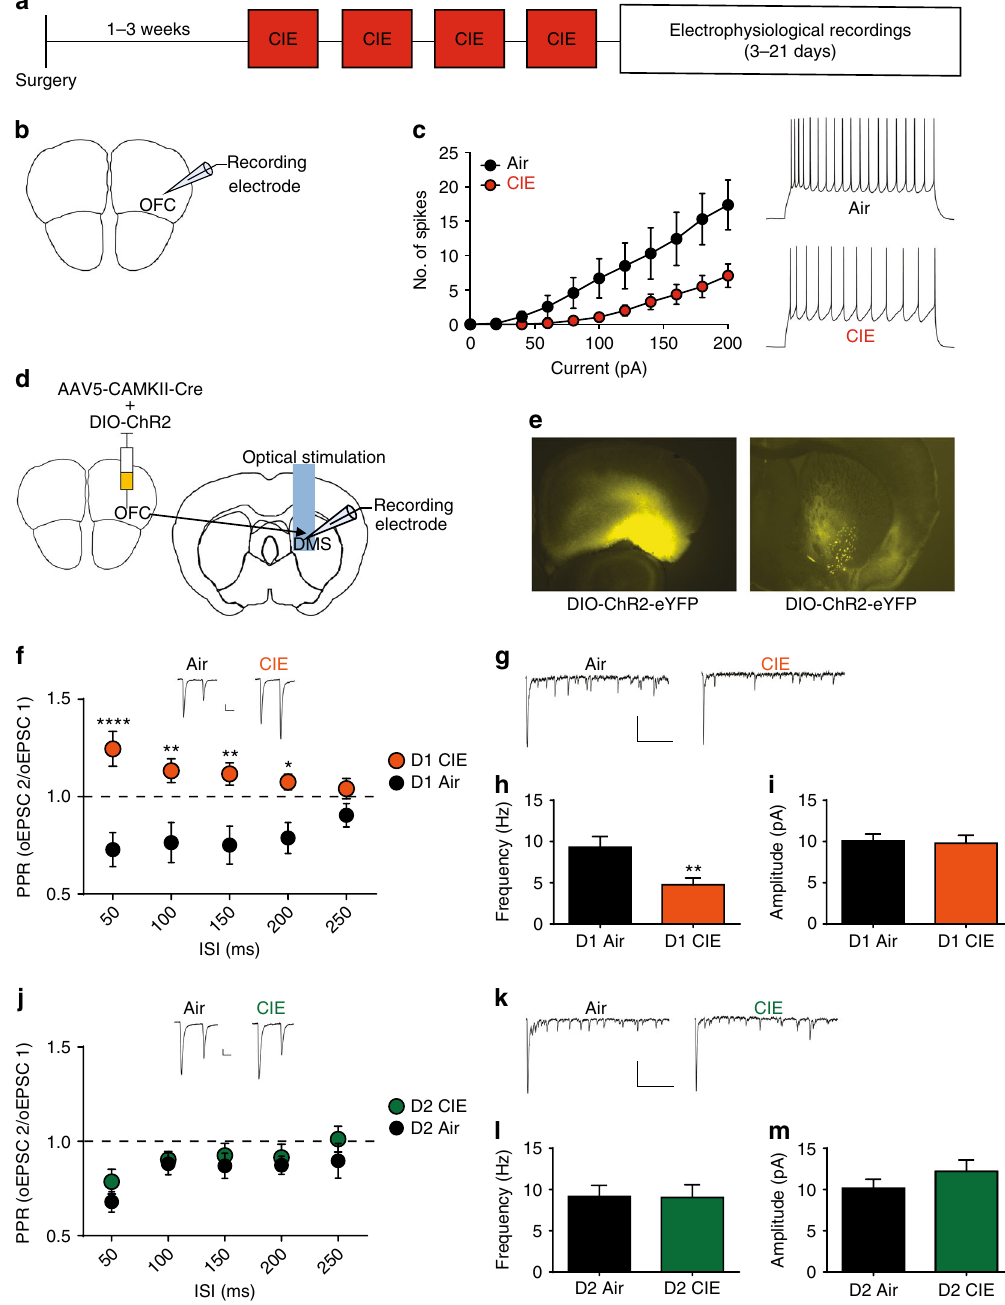
Fig. 2 CIE induces long-lasting disruptions to orbitostriatal circuits. a Experimental timeline used for electrophysiological recordings. Mice were given viral injections and allowed 2 – 4 weeks to recover before exposure to the CIE procedure. b Schematic of OFC recording site. c The number of spikes plotted against current injected (left) and representative traces of action potential fi ring at 200 pA (right) (3 cohorts, Air n = 8, CIE n = 11). d Schematic of OFC injection site and DMS recording site for optically induced currents. e Cre-dependent ChR2-YFP expression at the OFC injection site (left) and OFC terminals in the DMS (right). f Paired pulse ratio (PPR) of optically induced currents of OFC input to D1 SPNs. Scale bars represent 25 ms (horizontal) and 50 pA (vertical) (3 cohorts, Air n = 7, CIE n = 15). g Representative current traces of asynchronous release to D1 SPNS recorded in 2 mM Sr 2+ . Scale bars represent 250ms (horizontal) and 50 pA (vertical). h Average frequency of asynchronous release to D1 SPNs (Air n = 8, CIE n = 12). i Average amplitude of asynchronous release to D1 SPNs. j PPR of optically induced currents of OFC input to D2 SPNs (3 cohorts, Air n = 7, CIE n = 9). k Representative current traces of asynchronous release to D2 SPNs recorded in 2 mM Sr 2+ . l Average frequency of asynchronous release to D2 SPNs (Air n = 7, CIE n = 7). m Average amplitude of asynchronous release to D2 SPNs. Data points and bar graphs represent the average ± SEM. **** p < 0.0001, ** p < 0.01, * p <